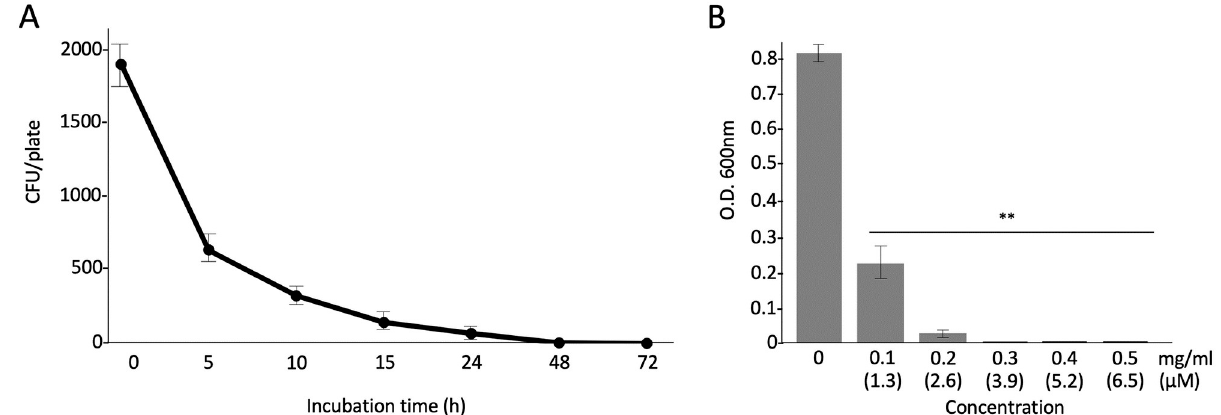
Fig 3. Bactericidal effect of bovine-derived lactoferrin (bLF) (A) and minimal inhibitory concentration (MIC) of bLF (B) on Streptomyces scabiei S58. For the assay of bactericidal effect, the mixture of bLF and spores (2 × 10 3 /mL) was incubated at 28 ˚C and directly cultured on starch agar in a time-dependent manner. The number of colonies emerging on the plates was counted. For the MIC assay, the mixture of bLF and spores (2 × 10 5 /mL) was incubated at 28 ˚C for 72 h in tryptic soy broth and the absorbance was measured at 600 nm to monitor bacterial growth. Error bars indicate the mean ± standard division of three independent experiments. Asterisks show a significant difference with respect to the control at �� p < 0.01 (Student’s t test).